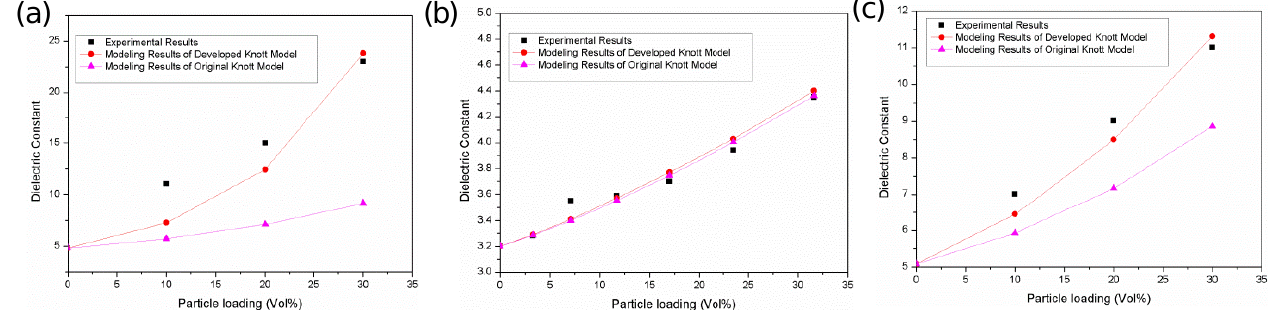
Figure 2. The experimental results and the modeling results of the dielectric constant of poly- mer-based nanocomposites ( a ) BaTiO 3 -epoxy resin [38], ( b ) Al 2 O 3 -epoxy resin [39], ( c ) Ba- TiO 3 -epoxy resin [40].